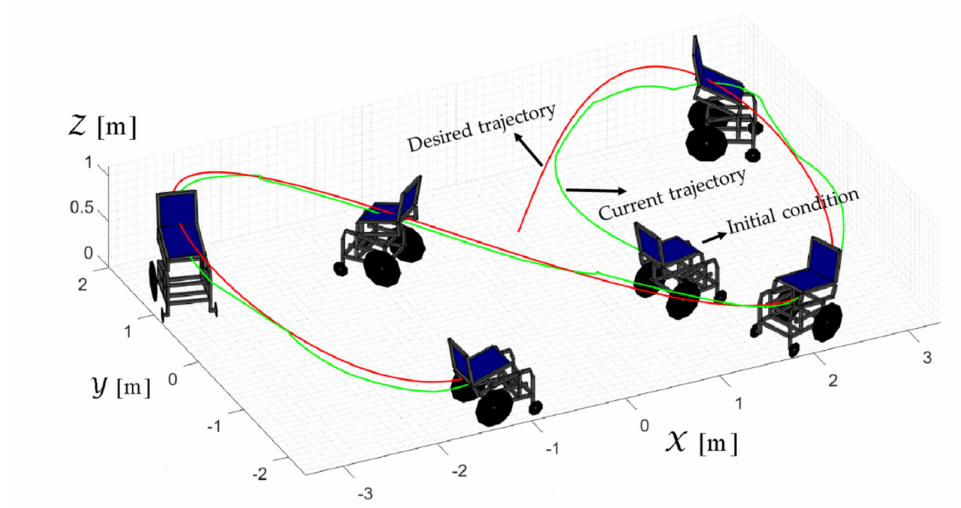
Figure 28. Stroboscopic movement of the human–robot system based on the real experimental